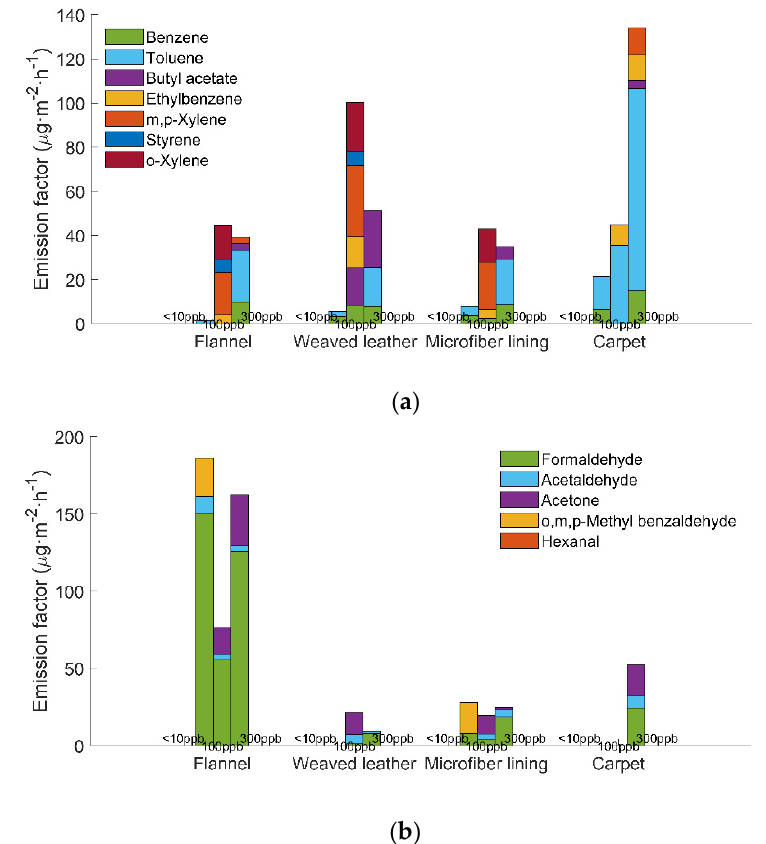
Figure 6. Primary and secondary emissions between the ozone and synthetic fibers. ( a ) Aromatics, esters, and aliphatic compounds. ( b ) Aldehydes and ketones.